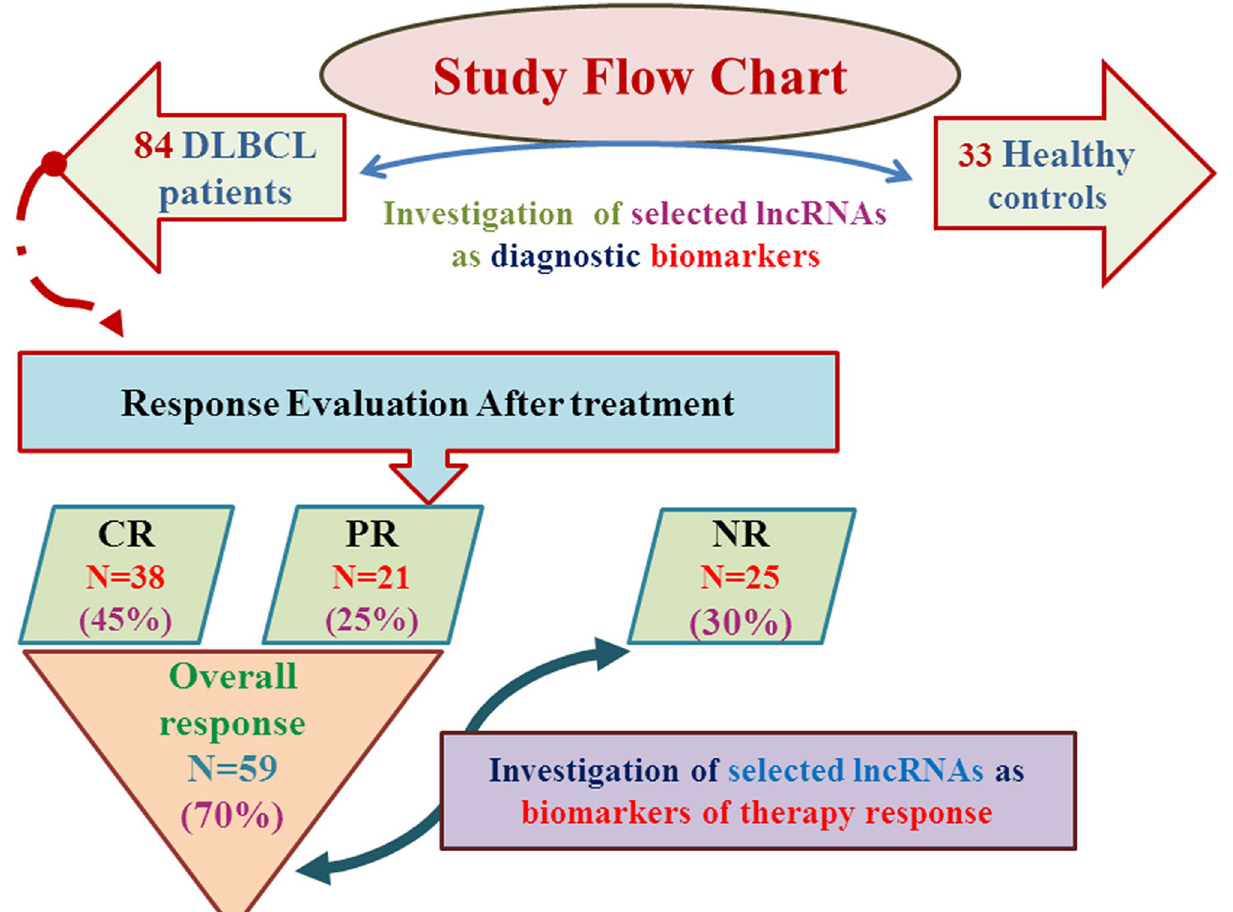
Figure 1. Flow chart of study design, patient classification, treatment response and analysis data sets. CR complete response, PR partial response, NR non-responders, N